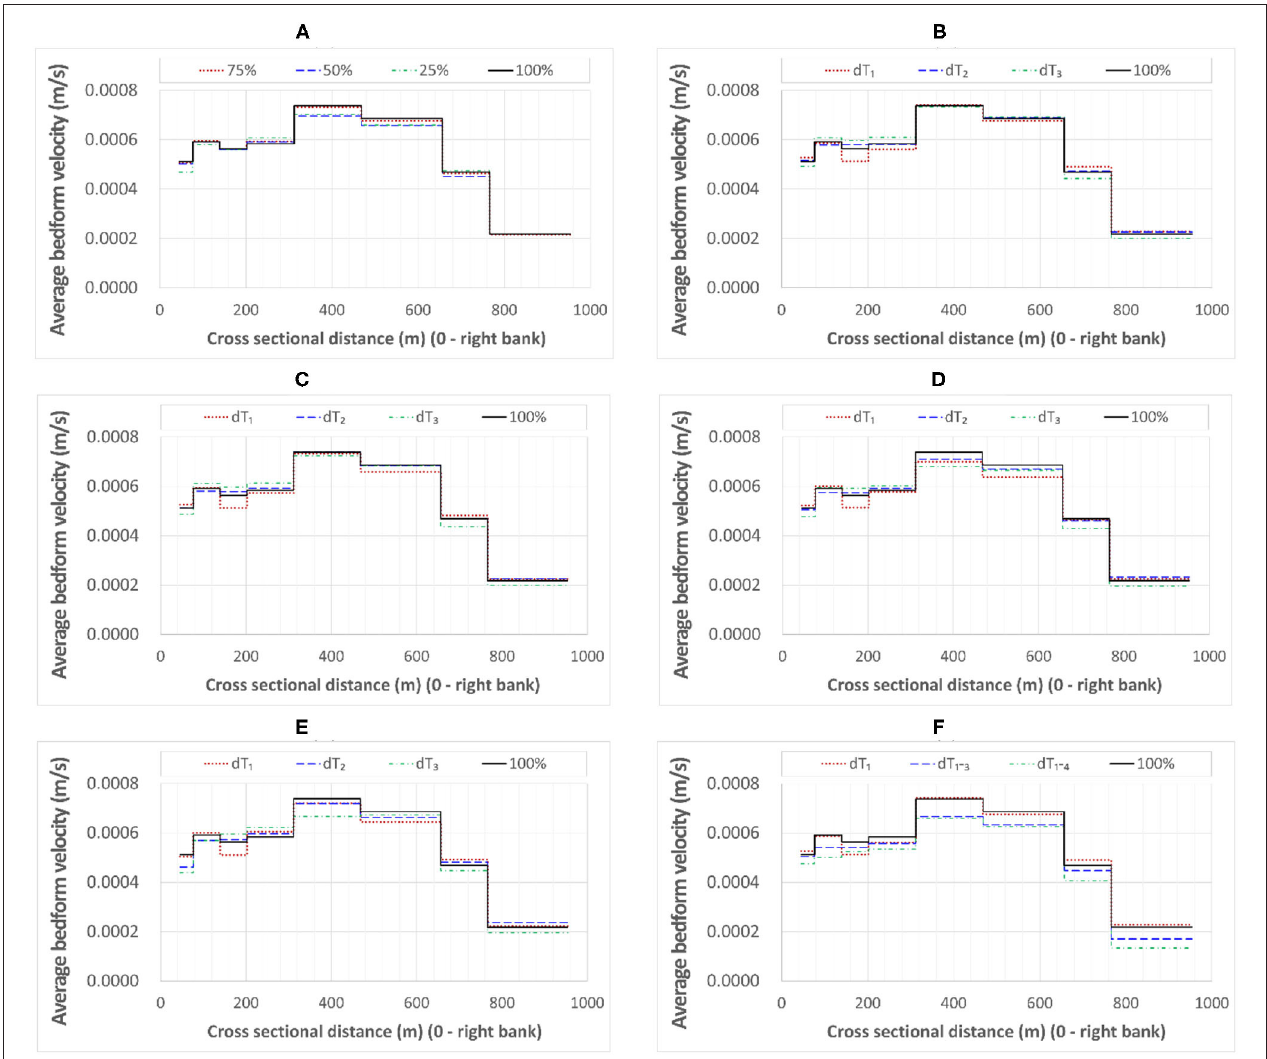
FIGURE 7 | Sensitivity of the bedform dynamics to the number of processed acoustic maps and length of the survey line (plotted as cross-sectional distributions): (A) average velocity field estimated with all acoustic maps and 100% (reference), 75, 50 and 25% of the full size acoustic image; (B) average bedform velocity field estimated from all the acoustic map pairs over full size of the maps (reference) compared with the same as obtained from image pair 1 and 2, pair 2 and 3, and pair 3 and 4; (C) average bedform velocity field estimated with all acoustic maps and full size map (reference), compared with 75% of the full size acoustic image; (D) average velocity field estimated with all acoustic maps and full size map (reference), compared with 50% of the full size acoustic image; (E) average bedform velocity field estimated with all acoustic maps and full size map (reference), compared with 25% of the full size acoustic image; (F) average velocity field estimated with all acoustic maps and full size map (reference), compared with the same obtained from pair 1 and 2, pair 1 and 3, and pair 1 and